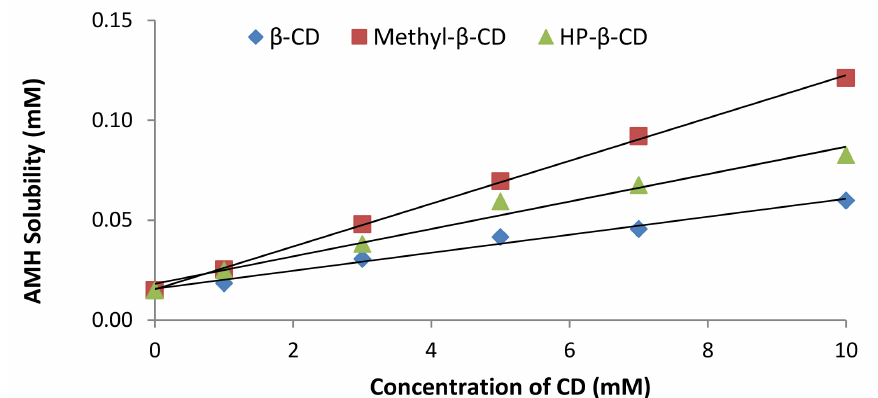
FIGURE 1 - Phase solubility diagrams of AMH in the presence of cyclodextrins in (A) 25 ºC and (B) 37 ºC ± 0.5 ºC ( n =